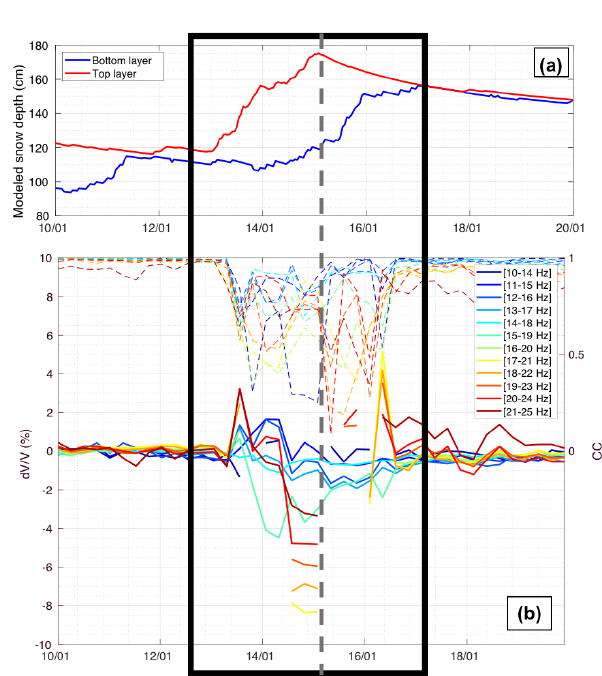
Figure 7. Same legend as Fig. 6, for snowfall event 2 (SF2).